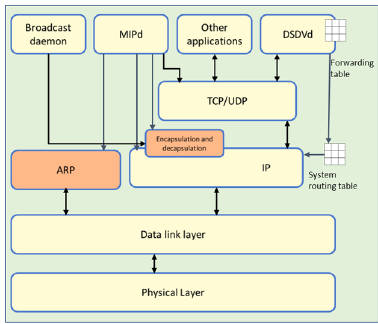
Figure 12. Integrating mobile IP with ad hoc networks [55].